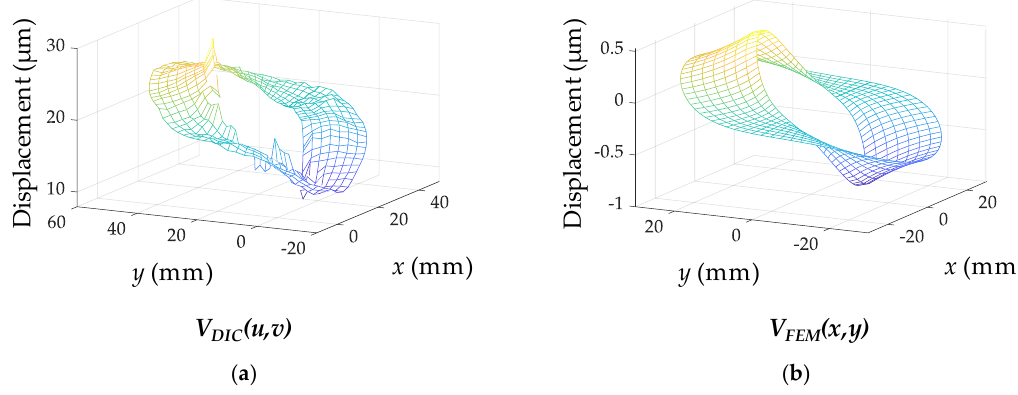
Figure 6. Displacement fields: ( a ) Obtained from DIC; ( b ) Obtained from ABAQUS.